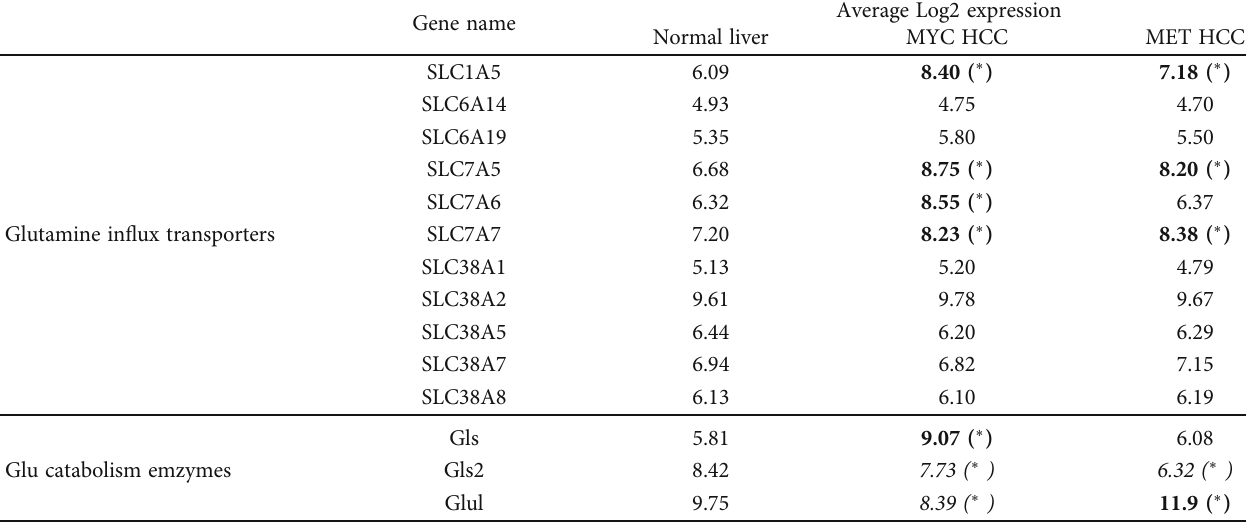
Table 1: Relative expression for major glutamine in fl ux transporters and catabolism enzymes in the normal liver, MYC HCC, and MET HCC tissues based on the microarray